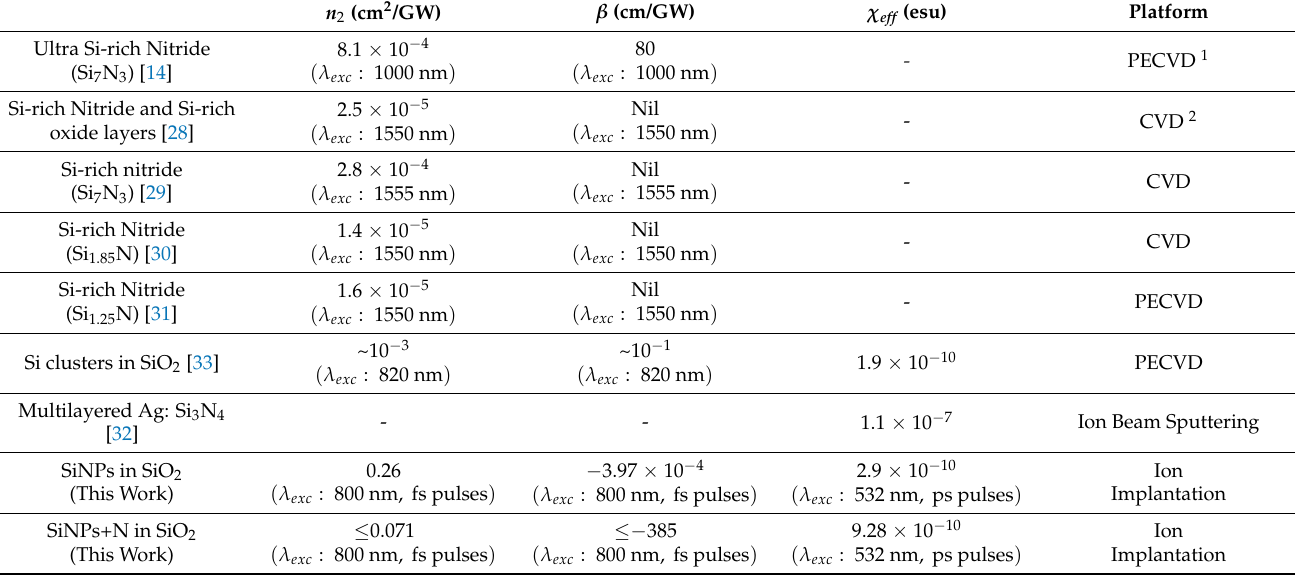
Table 2. Third-order nonlinear optical parameters for SiNPs and silicon nitride films. n 2 (cm 2